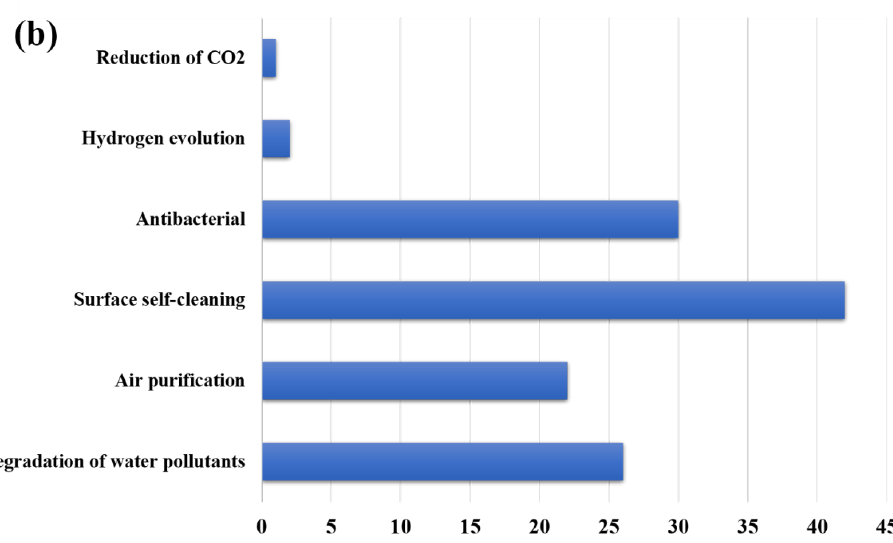
Figure 1. ( a ) Annual publications on PGCs (January 2002 – September 2022, Web of Science). ( b ) Publications on various applications of PGCs in the past decade (January 2002 – September 2022, Web of Science).